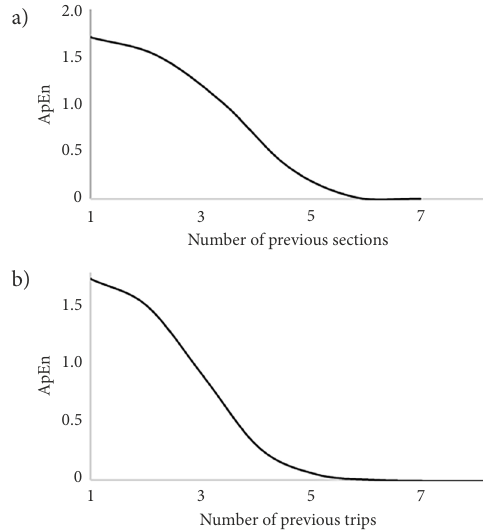
Figure 3. ApEn: a – vs number of previous sections; b – vs number of previous